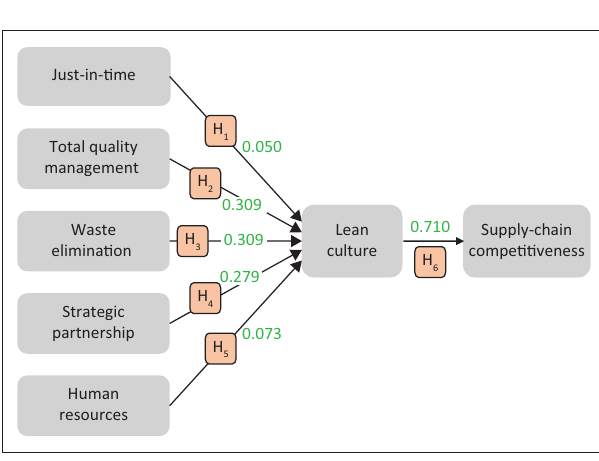
FIGURE 2: Path coefficient